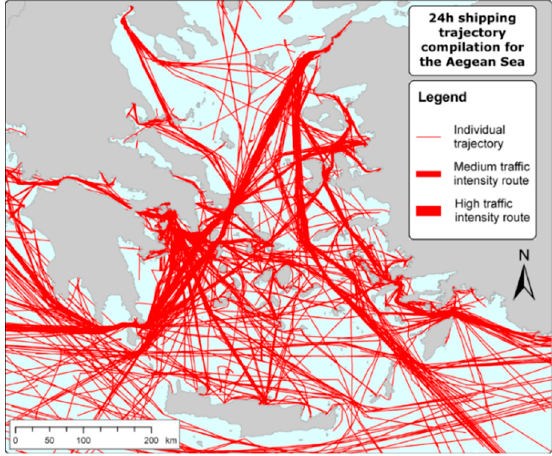
Figure 1. A 24h shipping trajectory compilation in the Aegean Sea. Source: Archipelagos®., Samos, Greece.